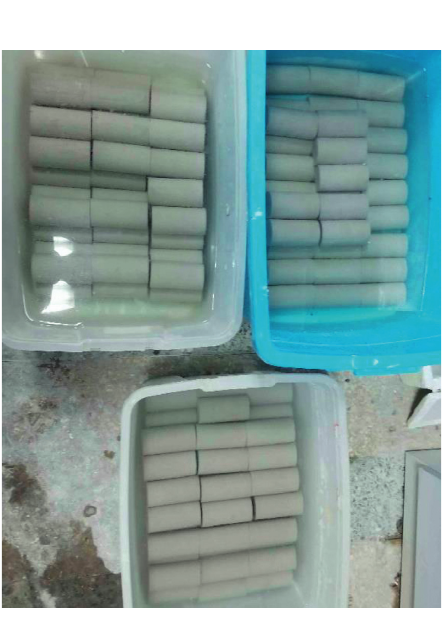
Figure 1: Specimen preparation.